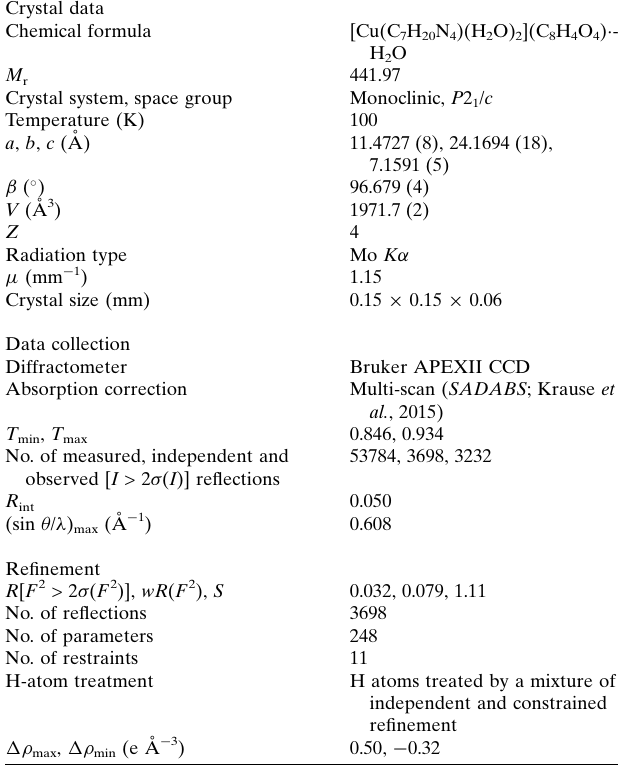
Table 3 Experimental details. Crystal data Chemical